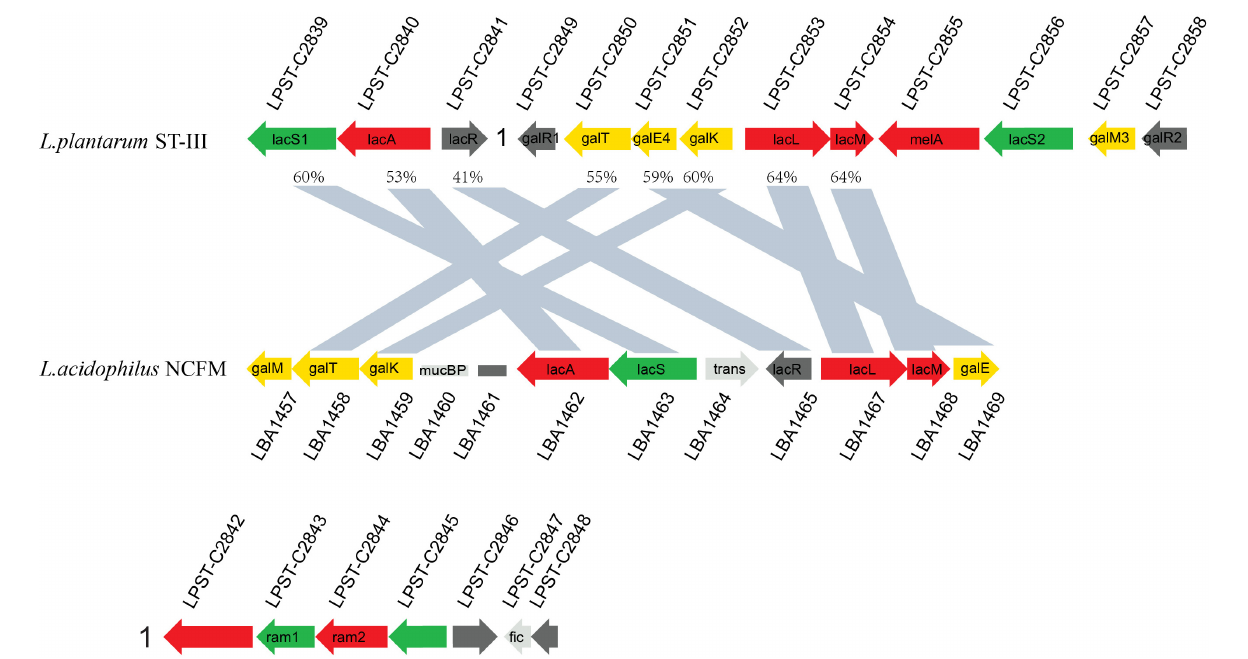
FIGURE 5 | Structural alignment of gene clusters identified within genome-sequenced lactobacilli and related LAB. Putative functions are indicated by color: carbohydrate permeases (green), transcriptional regulators (black), glycoside hydrolases (red), Leloir pathway (yellow), and genes not related to carbohydrate metabolism (gray). The similarity of the corresponding gene is marked on the